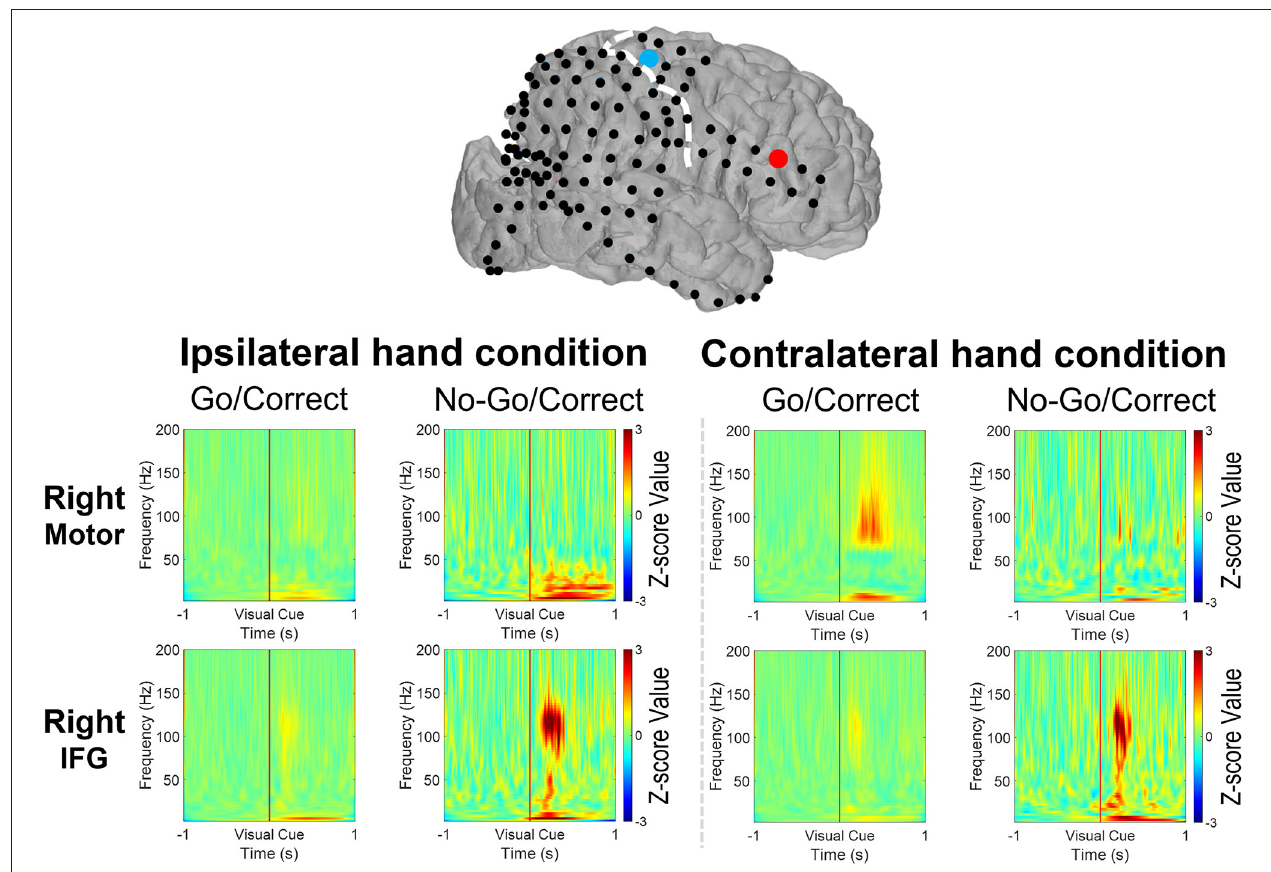
FIGURE 5 | The broadband spectral changes revealed the power change over the motor cortex (the blue dot) and the IFG (the right dot) from 1-second before to 1-second after the visual cues (Go or No-Go) by the 11-year-old with a right-side grid implanted. When the left hand was used, the power within the high-gamma band (HG, 70–200Hz) increased with the decreased beta band (12–40Hz) over the motor cortex after visual cues in the Go/Correct trials. Increased HG, beta, and theta (4–8Hz) power was noted when both the right and left hands were used in No-Go/Correct